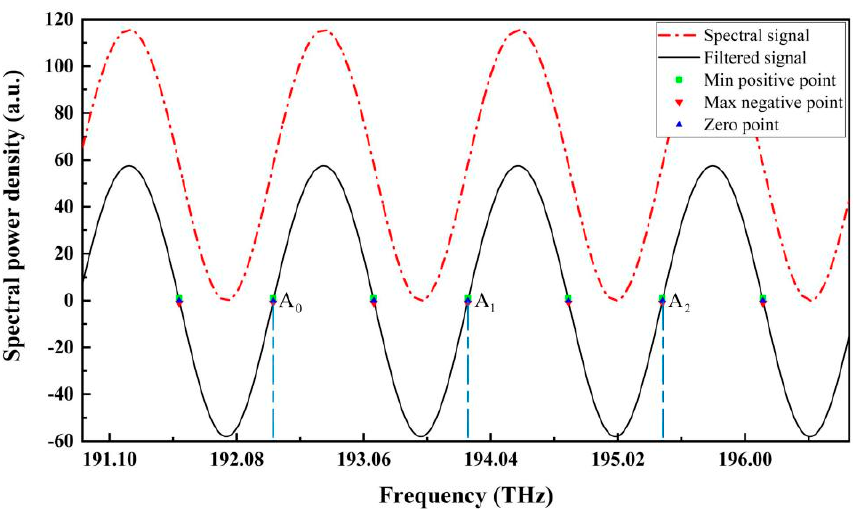
Figure 5. Simulated reflection spectrum in the optical frequency domain, in which A 0 , A 1 , and A 2 are three zero-cross points in ascending segments of the filtered spectral signal.